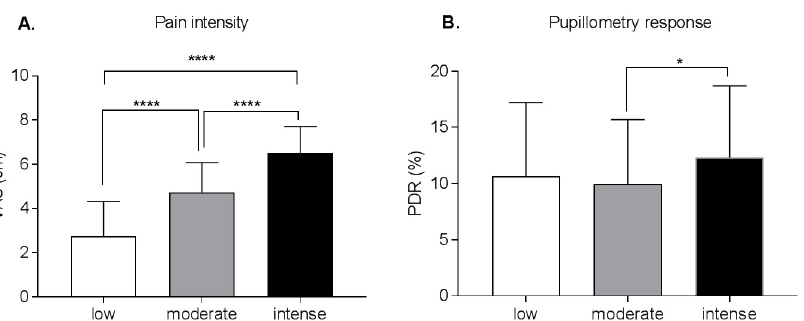
Fig 5. Pain intensity ratings (panel A) and pupillometry response (panel B) depending on the calibrated stimuli that were applied. The pain VAS ratings differed significantly between the applied stimuli that were calibrated as low, moderate and intense (A). Only moderate and intense stimuli conditions elicited significantly different pupillometry responses (B). VAS = visual analogue scale; PDR = pupillary dilatation reflex; ���� p < .0001 � p <